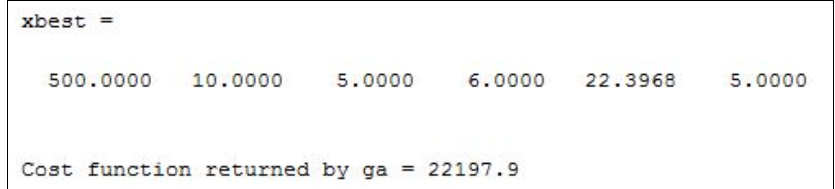
Figure 10. Optimal Sizing of System Components for microgrid without diesel